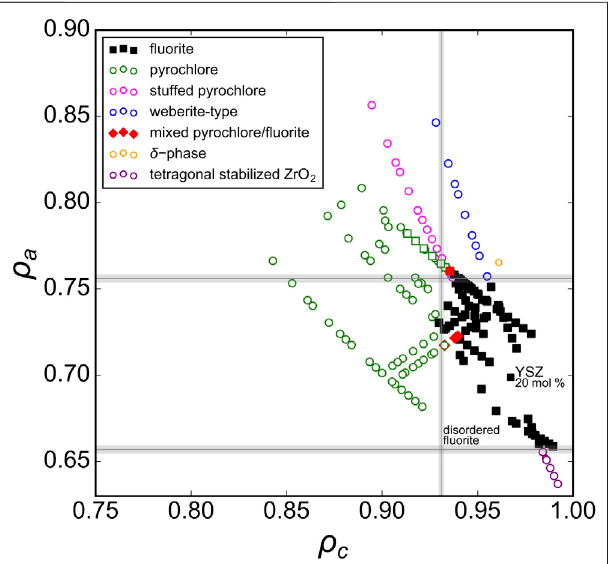
FIGURE 6 | Experimental data with a wide range of reported structures for A 2 B 2 O 7 , A 2 BO 5 , A 3 BO 7 , and A x B 1- x O 2-0.5 x oxides represented in the phase space created by the parameters ρ a and ρ c (de fi ned by Eqs 2 , 3 ). The different symbols are de fi ned in the legend and the gray lines denote the univalentradiiboundariesthatde fi nethestability fi eldofthedisordered fl uorite